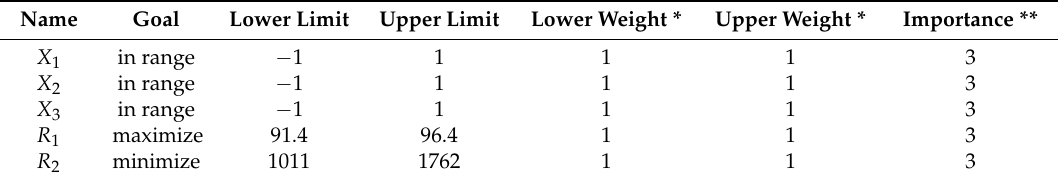
Table 7. Assumptions for the optimization of the ammonia oxidation process using desirability function. Variables symbol identification according to the Table 1.